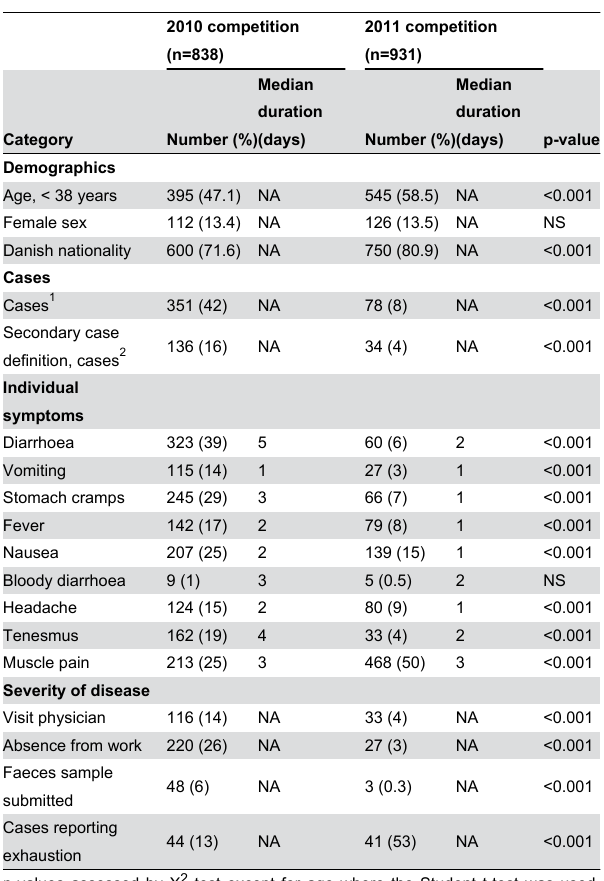
Table 1. Demographic characteristics, number of cases, symptoms and indicators of severity of disease among respondents following the 2010 and 2011 triathlon competitions, Copenhagen,